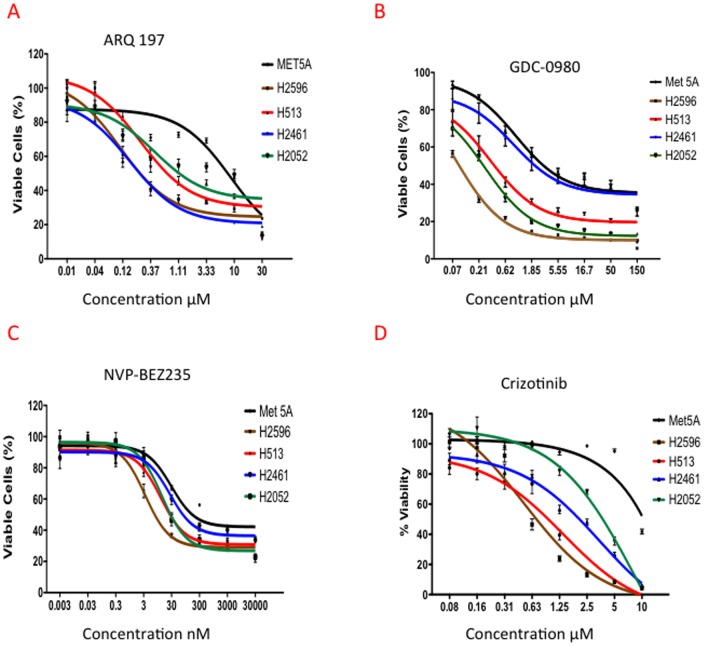
Effect of MET and PI3K/mTOR dual inhibitors on growth of human mesothelioma tumor cell lines.Met-5A, H2596, H513, H2461 and H2052 were treated with ARQ 197, NVP-BEZ235, and GDC-0980 for 72 h at the indicated concentrations. Viability was measured by Alamar Blue assay. The data shown represent the mean ± SEM. (A) ARQ 197, (B) GDC-0980, (C) NVP-BEZ235, (D) Crizotinib.